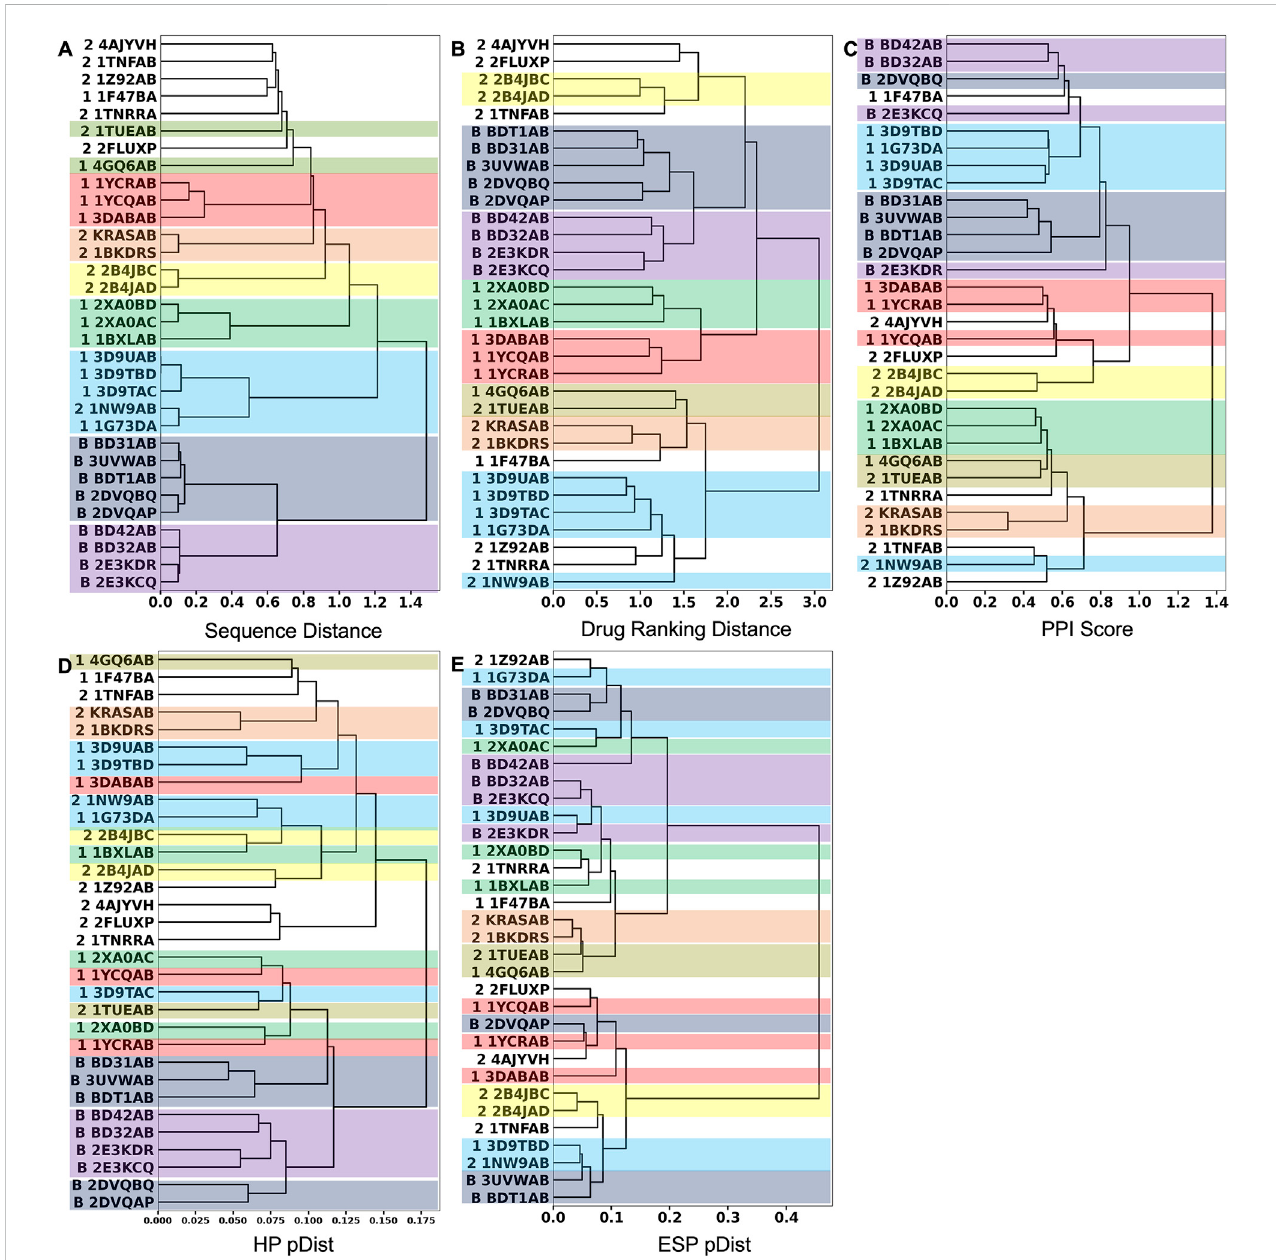
FIGURE 4 Hierarchical clustering of the 32 PPIs in the 2P2I database. We used the Ward ’ s clustering method. (A) clustering results using the sequence distance. (B) Clustering results using the drug ranking distance. (C) Clustering results using the PPI Score. (D) Clustering results using only the hydrophobicity term to quantify patch similarity in the PPI Score. After the corresponding patch pairs were identi fi ed between two PPIs, only the hydrophobicity term was used to compute pDist score (Eq. 6). (E) Clustering result using only the electrostatic potential term in pDist . In the dendrogram, the 2P2I class of each PPI is denoted in front of the PDB ID as follows: 1 for protein-peptide, 2 for protein-protein, and B for bromodomain. Entries in the same cluster by the sequence- distance are shown in the same color across the three